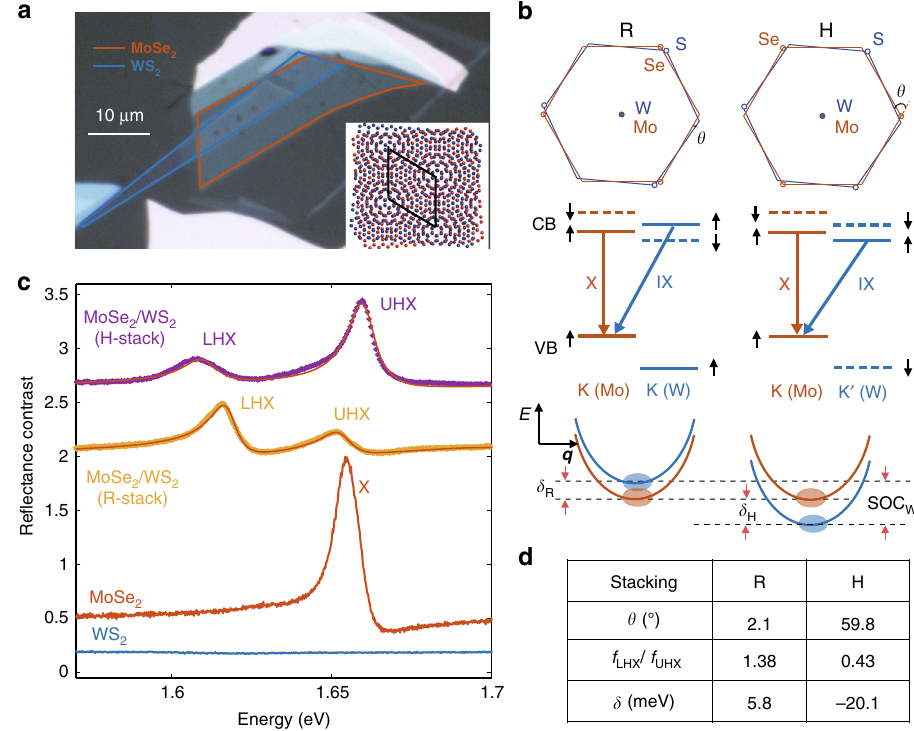
Fig. 1 Hybrid excitons in rotationally aligned WS 2 /MoSe 2 bilayers. a An optical microscope image of a hexagonal boron nitride (hBN)-capped heterobilayer. Red and blue solid lines outline the MoSe 2 and WS 2 monolayers, respectively. The inset is an atomistic model of the WS 2 /MoSe 2 heterobilayer. Red and blue spheres represent MoSe 2 and WS 2 monolayers, respectively. The black solid diamond represents the moiré unite cell. b Top panels illustrate a unit cell of R-stacking (left) and H-stacking (right) WS 2 /MoSe 2 bilayers. Middle panels depict the corresponding band alignment of WS 2 and MoSe 2 , where X labels the intralayer transition and IX labels the nearly resonant interlayer transition that shares the same hole state. Solid and dashed lines correspond to states of opposite spins. Bottom panels illustrate the alignment between an intralayer MoSe 2 A exciton state (red) and the interlayer exciton state (blue) that it hybridizes with. c Re fl ectance contrast (RC) spectra for, from bottom to top, a monolayer WS 2 (blue), monolayer MoSe 2 (red), R-stacking bilayer (orange), and H-stacking bilayer (purple). The dots are the data, and solid lines are fi ts. The spectra are displaced vertically for easier reading. d Summary of the fi tted ratio of the oscillator strength between LHX and UHX, and the corresponding detuning δ